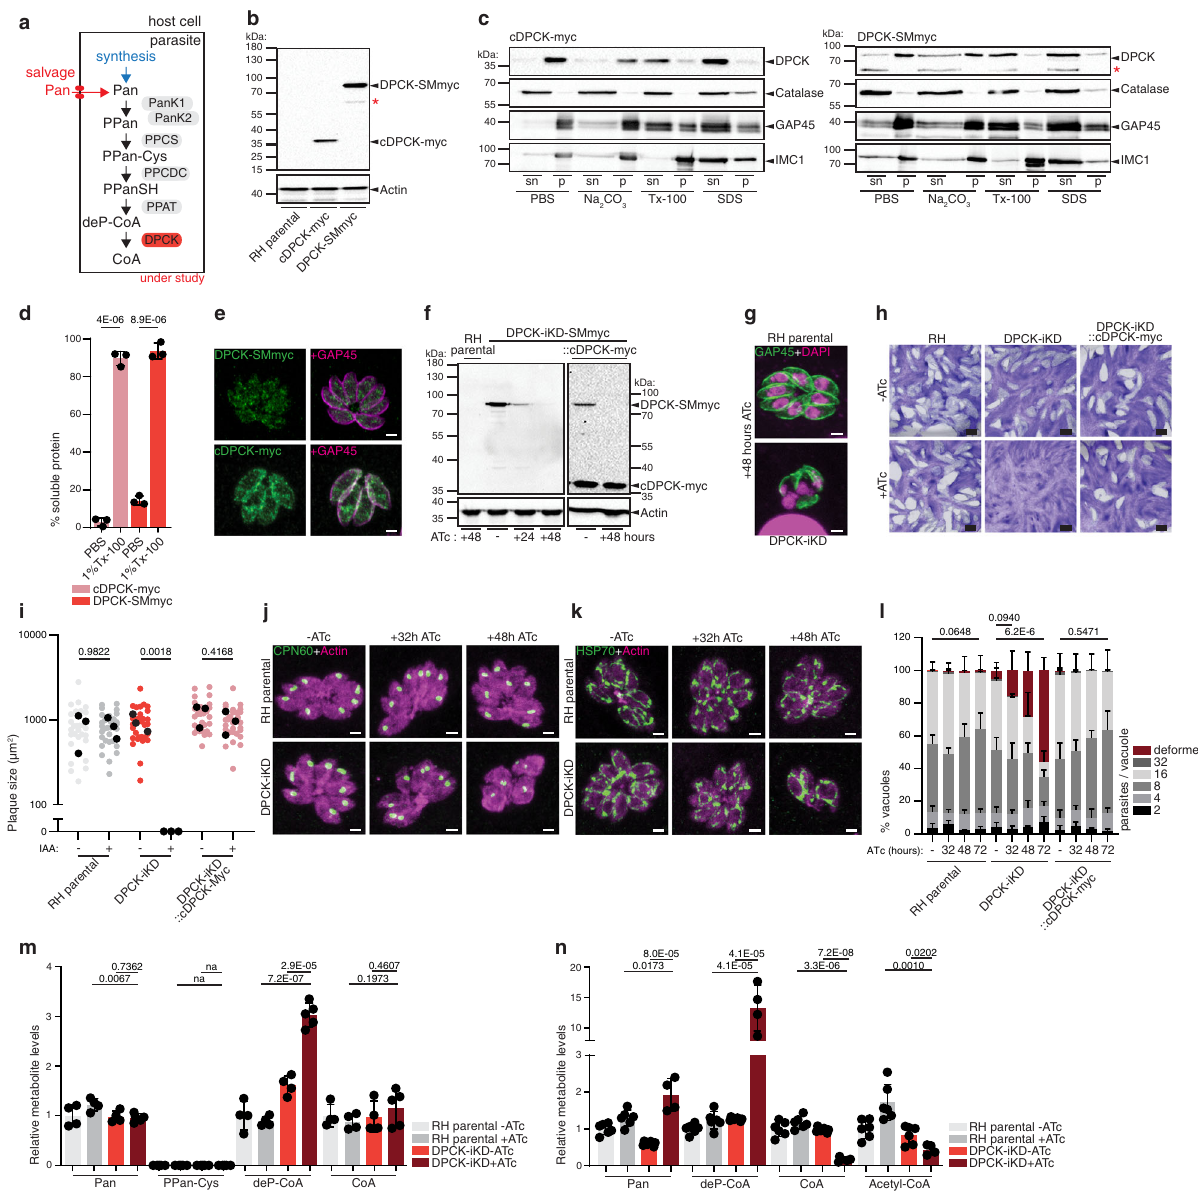
Fig. 4 The fi nal step of CoA biosynthesis is essential in T. gondii and relies on a membrane-bound cytoplasmic DPCK. a Scheme of CoA biosynthesis pathway, highlighting the fi nal CoA synthesis enzyme dephospho-CoA kinase (DPCK). See Fig. 1 for abbreviations. b Western blot of cDPCK-myc (expected MW 37 kDa, n = 3) and spaghetti-monster (SM)myc tagged DPCK (expected MW 72 kDa, n = 3). Antibodies anti myc and anti actin as loading control. c Western blot of solubility assay of cDPCK-myc ( n = 3) and DPCK-SMmyc ( n = 3). Antibodies anti myc/ anti-catalase, anti GAP45 and anti IMC1 as markers for PBS-, Triton- and SDS-soluble fraction, respectively. sn supernatant, p pellet. Solubility quanti fi ed in d ( n = 3, mean and SD). e IFA of cDPCK- myc ( n = 3) and DPCK-SMmyc tagged strains ( n = 3). Antibodies: anti myc, anti GAP45 as marker of parasite pellicle. f Western blot of DPCK-iKD-SMmyc and cDPCK-myc protein levels upon anhydrotetracycline (ATc) addition. Antibodies anti myc, anti actin as loading control ( n = 3). g IFA of 48 h ATc treated DPCK-iKD. Antibodies: anti GAP45 (parasite pellicle), DAPI (nucleus) ( n = 3). h Plaque assay of DPCK-iKD and DPCK-iKD::cDCPK-myc ( n = 3). i Quanti fi cation of plaque size. Black dots present the average of each independent experiment. ( n = 3, 2-sided t -test). j , k IFAs of apicoplasts and mitochondria in DPCK-iKD, at the indicated timepoints of ATc addition. Antibodies: anti actin (cytoplasm), anti-CPN60 (apicoplast), anti-HSP70 (mitochondrion) ( n = 3). l Intracellular growth assay of RH and DPCK-iKD parasites over 24 h. Deformed parasites scored as indicated in Fig. 1h ( n = 3 – 6, mean and SD, 2 tailed t -test on “ deformed ” category). m , n LC-MS analysis of metabolite abundances in DPCK depleted parasites (32 h ATc, m; 72 h ATc, n ). n = 4 – 5 for m and 5 – 6 for n , mean and SD, 2-sided Student ’ s t test). Metabolite levels normalized to internal standard ( 13 C 6 / 15 N-isoleucine for n and 13 C 15 N-pantothenate for m) and quanti fi ed relative to RH − ATc. n number of independent biological replicates. Source data are provided as a Source 3 / Data fi le. White scale bar 2 µ m, black scale bar 1 mm. Red asterisks indicate degradation products of the tagged protein.